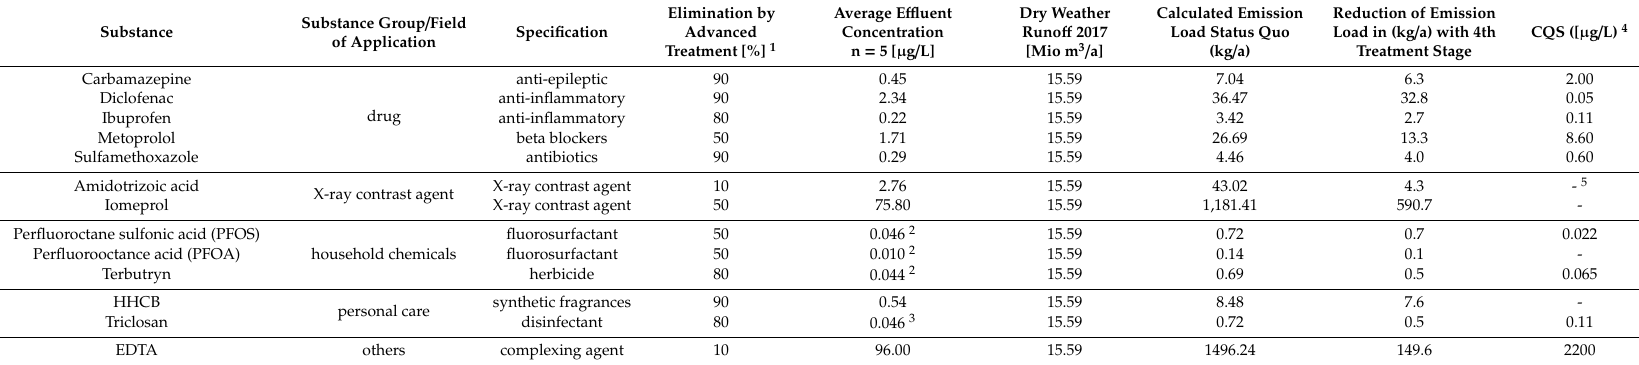
Table 5. Assessment of the environmental relief through implementation of the advanced treatment for OMP removal at WWTP Mainz (elimination values based on experiences from full-scale WWTPs with the single stage OMP